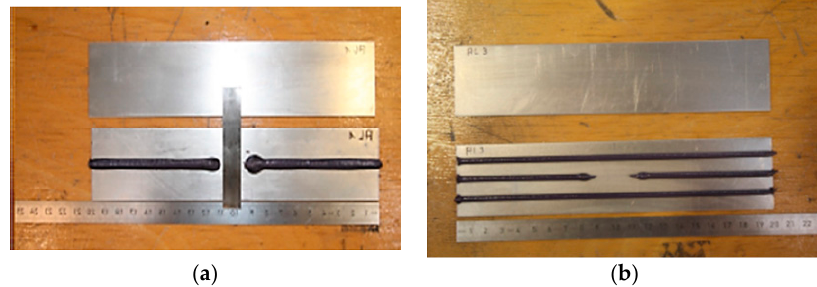
Figure 5. The application of adhesive to the aluminum plates while creating debonding damage: ( a ) adhesive bonded aluminum plate 1; and ( b ) adhesive bonded aluminum plate 2.